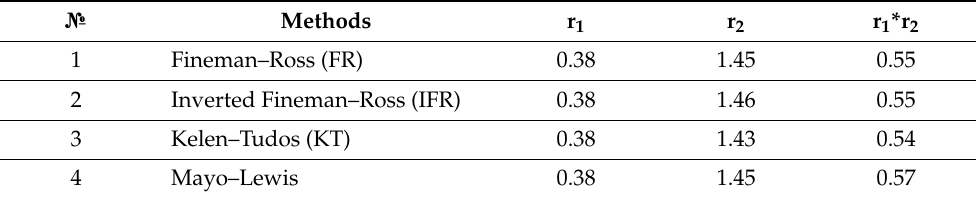
Figure 2. Fineman–Ross ( a ) and inverted Fineman–Ross ( b ) plots of poly(DMA-co-AAc). Table 2. Copolymer constants based on Fineman–Ross, inverted Fineman–Ross, Kelen–Tudos and Mayo–Lewis